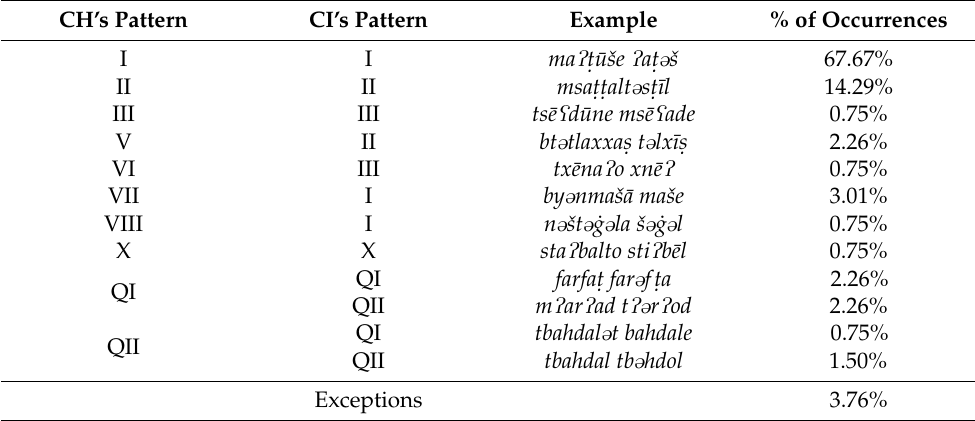
Table 3. Pattern correspondence between CIs and CHs in LA and percentage of occurrence in the